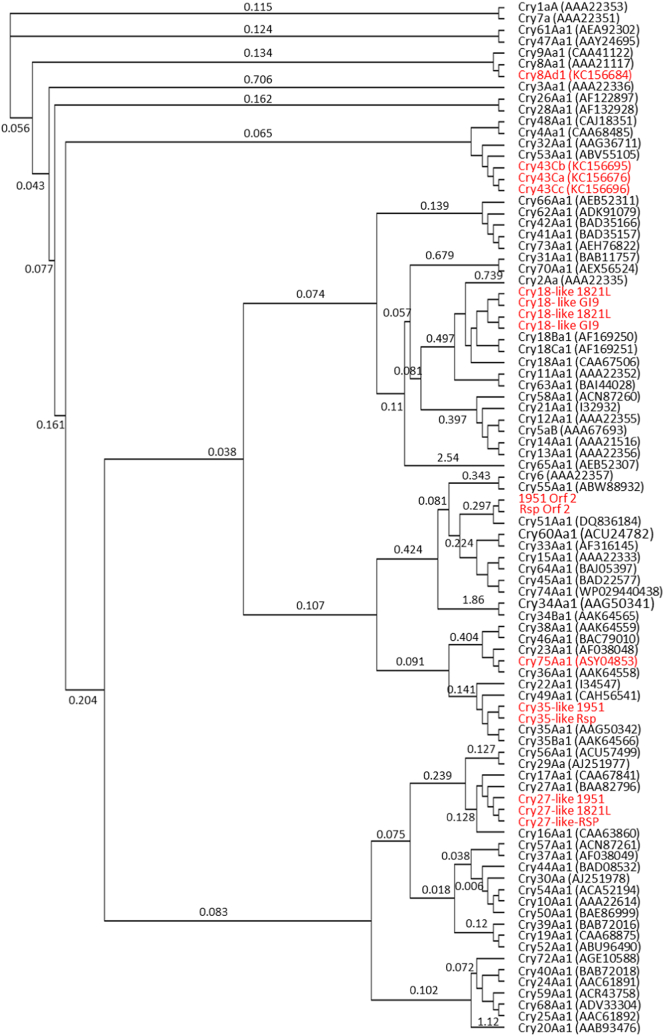
Cry protein phylogeny. In red are Cry proteins from Brevibacillus laterosporus, with New Zealand isolates 1821L, 1951 and Rsp labelled. Cry 75 and Cry18 were present in GenBank records; Cry43 and Cry8 from B. laterosporus were previously reported in a patent [69]. Numbers on branches are substitutions per site. Figure was generated using FastTree in Geneious following MUSCLE alignment using the CLUSTAL algorithm. (For interpretation of the references to colour in this figure legend, the reader is referred to the web version of this article.)